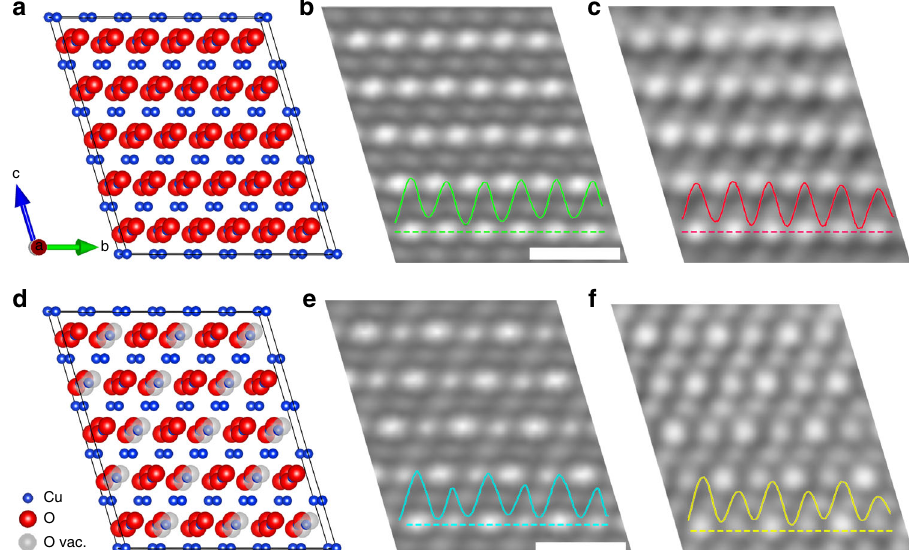
Fig. 3 Structural interpretation of the superlattice contrast in CuO. a Perfect CuO, viewed along the ½ (cid:1) 1 (cid:1) 1 (cid:1) 1 (cid:2) direction, blue and red balls represent Cu and O atoms, respectively. b Simulated ½ (cid:1) 1 (cid:1) 1 (cid:1) 1 (cid:2) zone-axis HRTEM micrograph of the perfect CuO. c Zoomed-in experimental HRTEM micrograph of the CuO lattice as shown in Fig. 1a. d CuO superstructure model consisting of 50% oxygen vacancies in every other Cu – O column (the positions of oxygen vacancies are represented by gray balls). e Simulated ½ (cid:1) 1 (cid:1) 1 (cid:1) 1 (cid:2) zone-axis HRTEM micrograph based on the superlattice structure model shown in d . f Zoomed-in experimental HRTEM micrograph of the CuO superlattice shown in Fig. 1d. Insets are intensity pro fi les along the dashed lines in b , c , e , f , respectively. Parameters used for HRTEM image simulations are given in Methods. Scale bar, 0.5 nm ( b , e